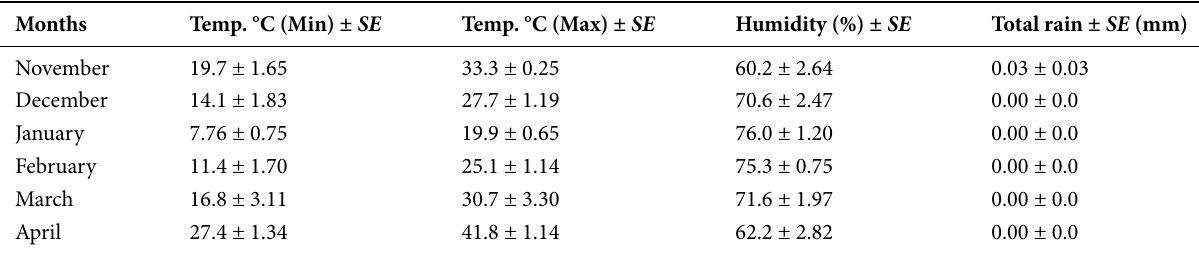
Table 2 Weather conditions including minimum (Min), and maximum (Max) temperature (Temp.) and humidity followed by standard error ( SE ) recorded during the field